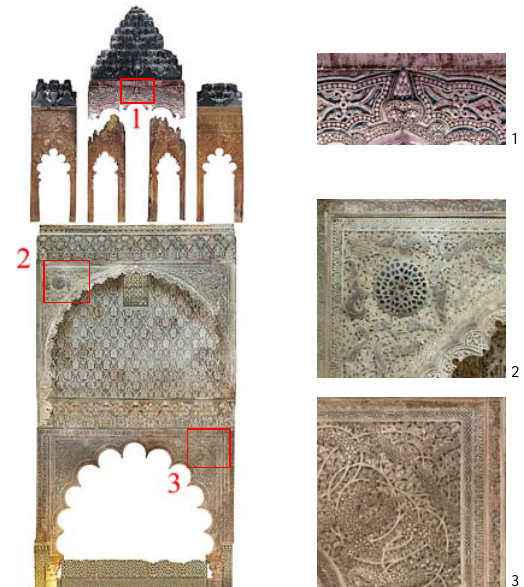
Figure 13. Orthoimage of north side wall. Windows and central rib (from mosaics of rectified images) are also projected on the north plane. Point cloud from the dome is also projected on top.